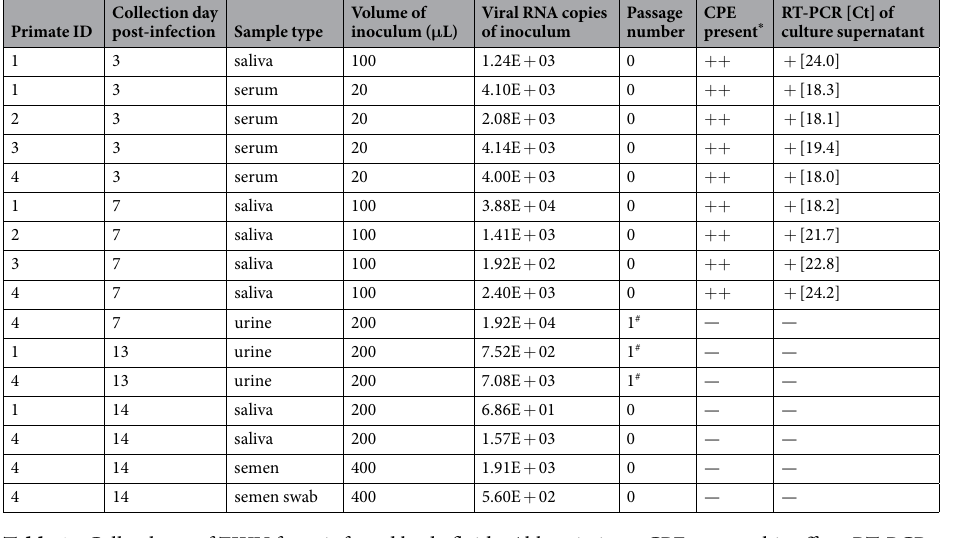
Table 1. Cell culture of ZIKV from infected body fluids. Abbreviations: CPE, cytopathic effect; RT-PCR, reverse-transcriptase polymerase chain reaction; Ct, cycle threshold. * − , no CPE, + , mild-moderate CPE ( < 0–25%), ++ , heavy CPE ( > 25%), reported from duplicate wells; cells were monitored daily for up to 14 days or until CPE was observed #atypical cytotoxicity observed at passage 0, so cell culture supernatants passaged once in Vero